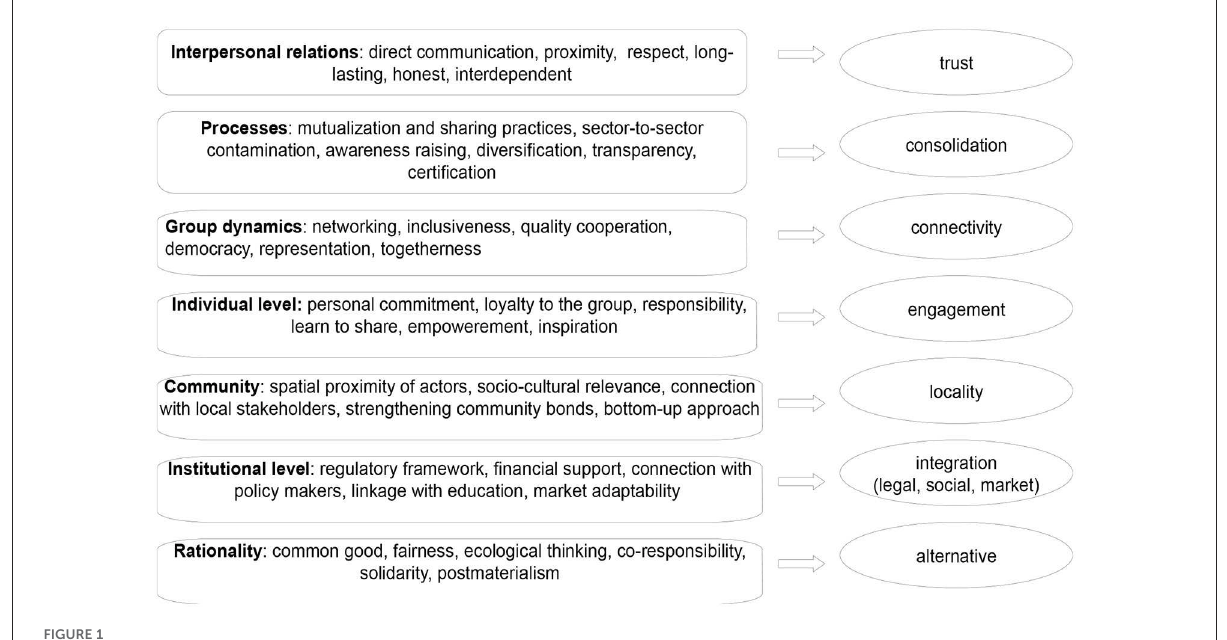
FIGURE1 Frames, keywords, and central features of SFSC.